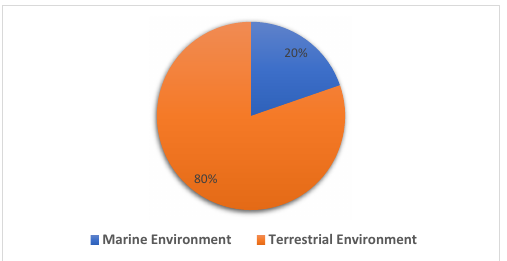
Figure 3. Distribution of novel Streptomyces spp. recorded in terrestrial and marine environment between 2015 and 2020, with 80% sourced from terrestrial environments and 20% reported from the marine environment.